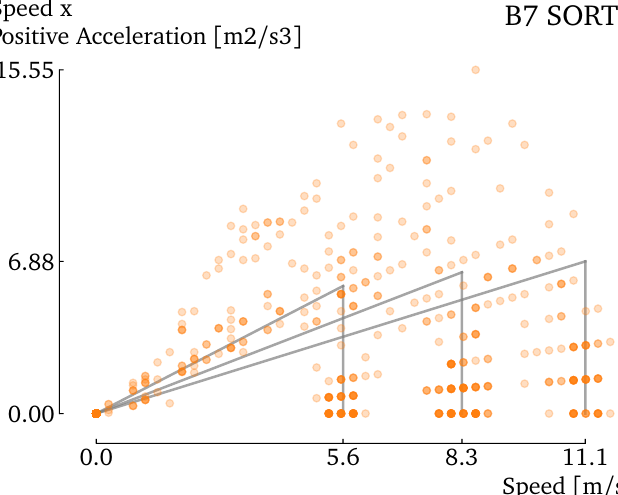
Figure 4. The instantaneous velocity times positive acceleration of the repetitions cover a more aggressive region of the SORT guideline leading to conservative results.